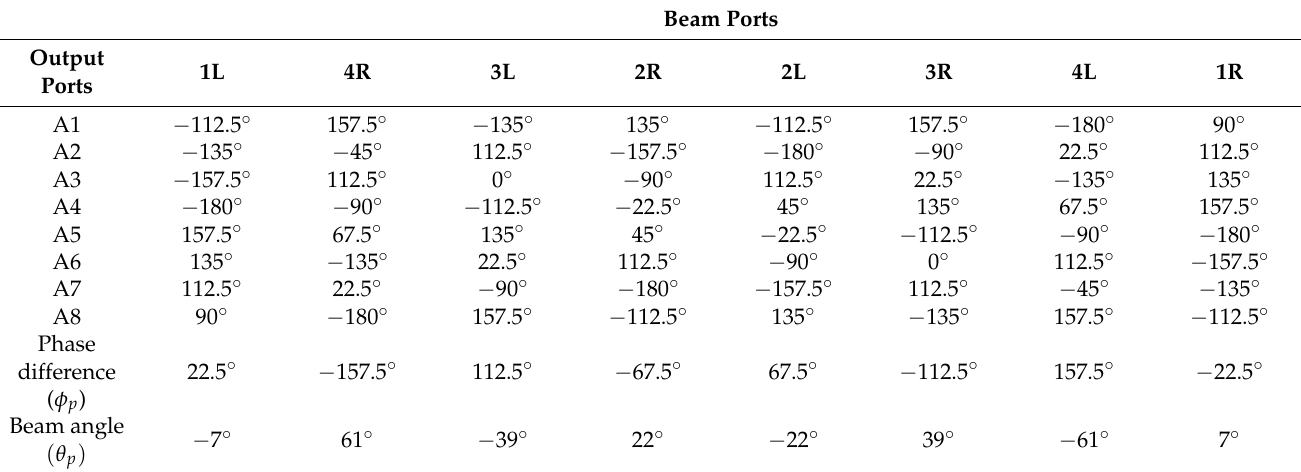
Table 3. Phase distribution in an 8 × 8 Butler